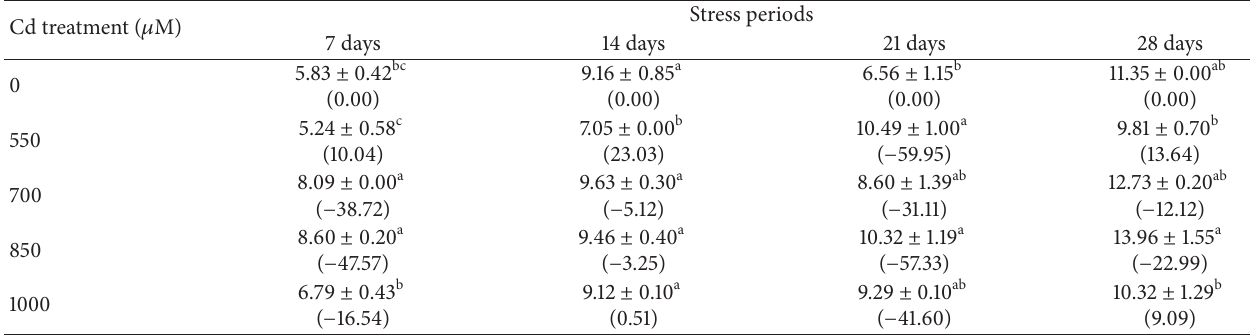
Table 4: MDA contents (nmolg − 1 FW) of cotton callus culture (cv. YZ1) grown under various levels of cadmium. Cd treatment ( 𝜇 M)